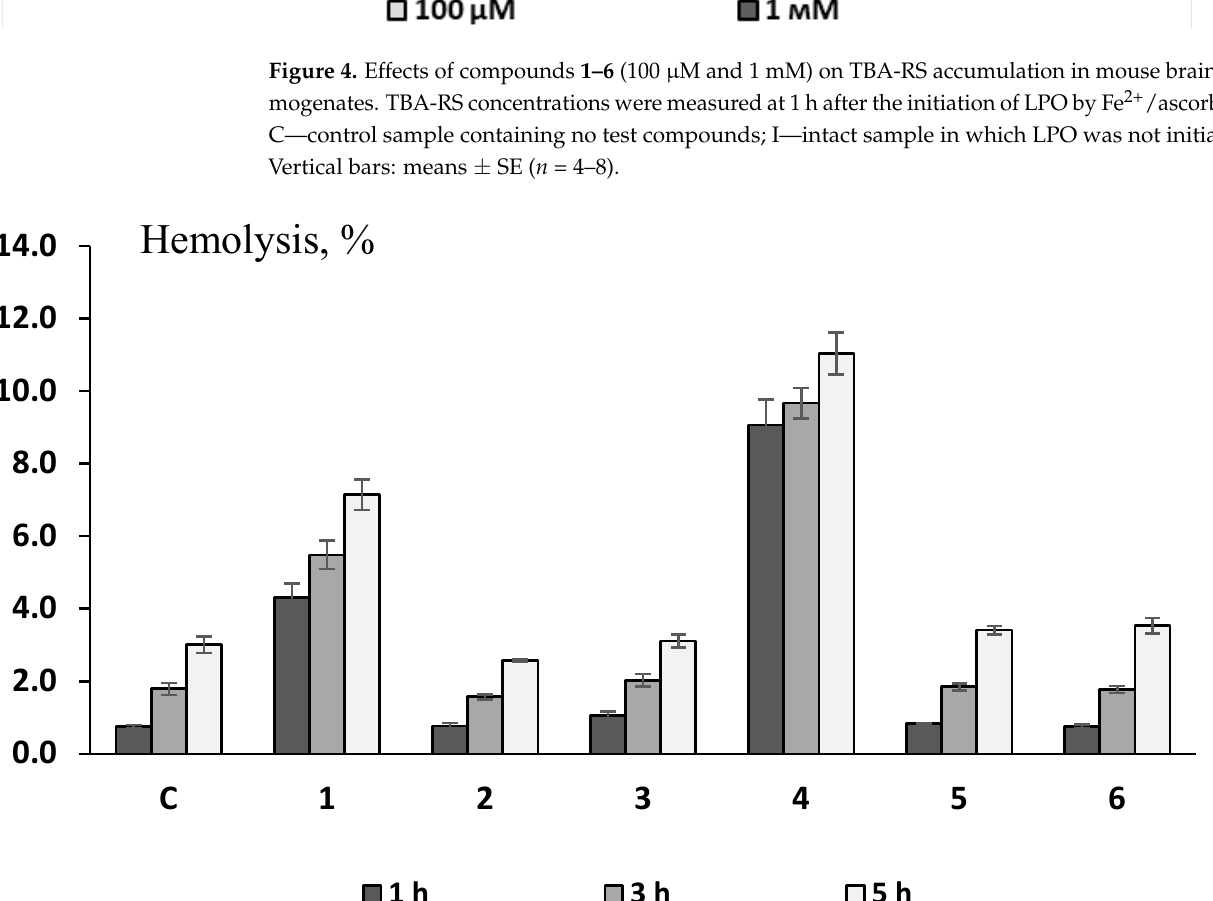
Figure 5. Hemolytic activity (erythrotoxicity) of compounds 1–6 (100 µ M) after 1, 3 and 5 h of erythrocytes incubation. Vertical bars: means ± SE ( n = 3–6).